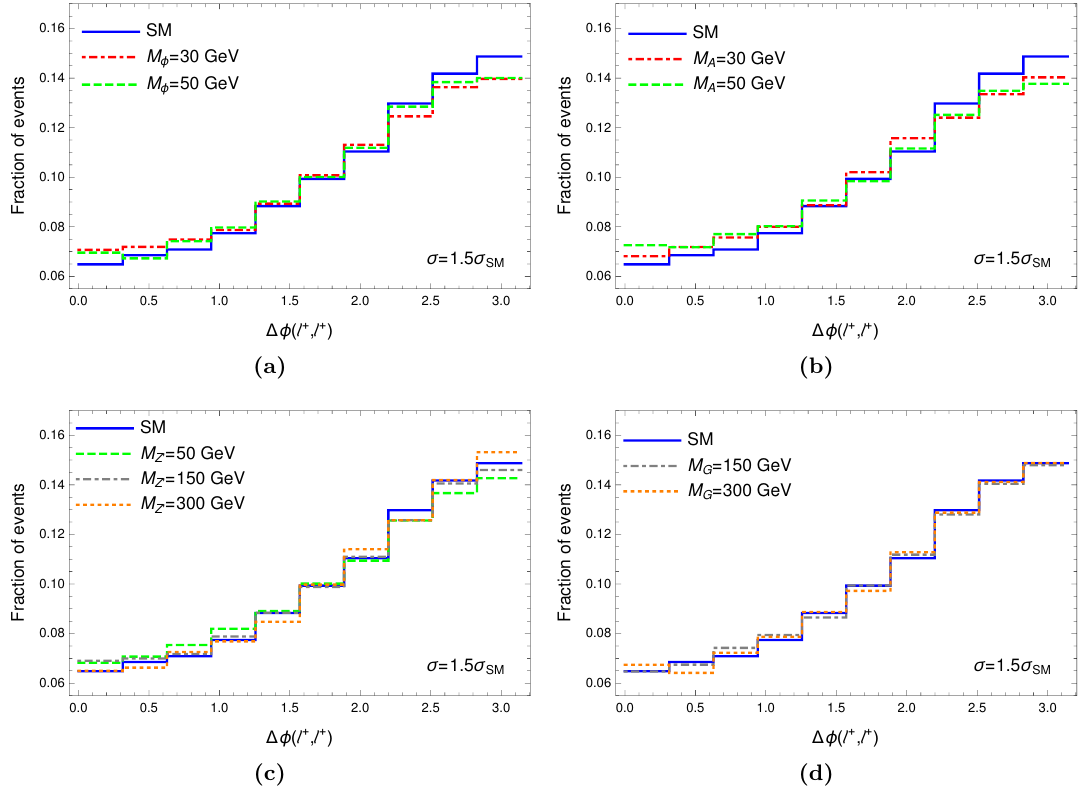
Figure 7. Distribution of the azimuthal separation between the same-sign leptons, (cid:1) (cid:30) ( ‘ + ; ‘ + ), for the 2LSS channel after preselection (see text for details), normalized to unit area. Shown are the predictions for the SM (blue) and the tight benchmark points (i.e. giving (cid:27) = 1 : 5 (cid:27) SM ) of the NP models considered: (a) Scalar, (b) Pseudo-scalar, (c) Z 0 , and (d) Graviton. Analogous results for the loose benchmark points (i.e. giving (cid:27) = 2 (cid:27) SM ) are shown in (cid:12)gure 10 in appendix A. These same results in two bins of H T are shown in (cid:12)gures 11{14 in appendix